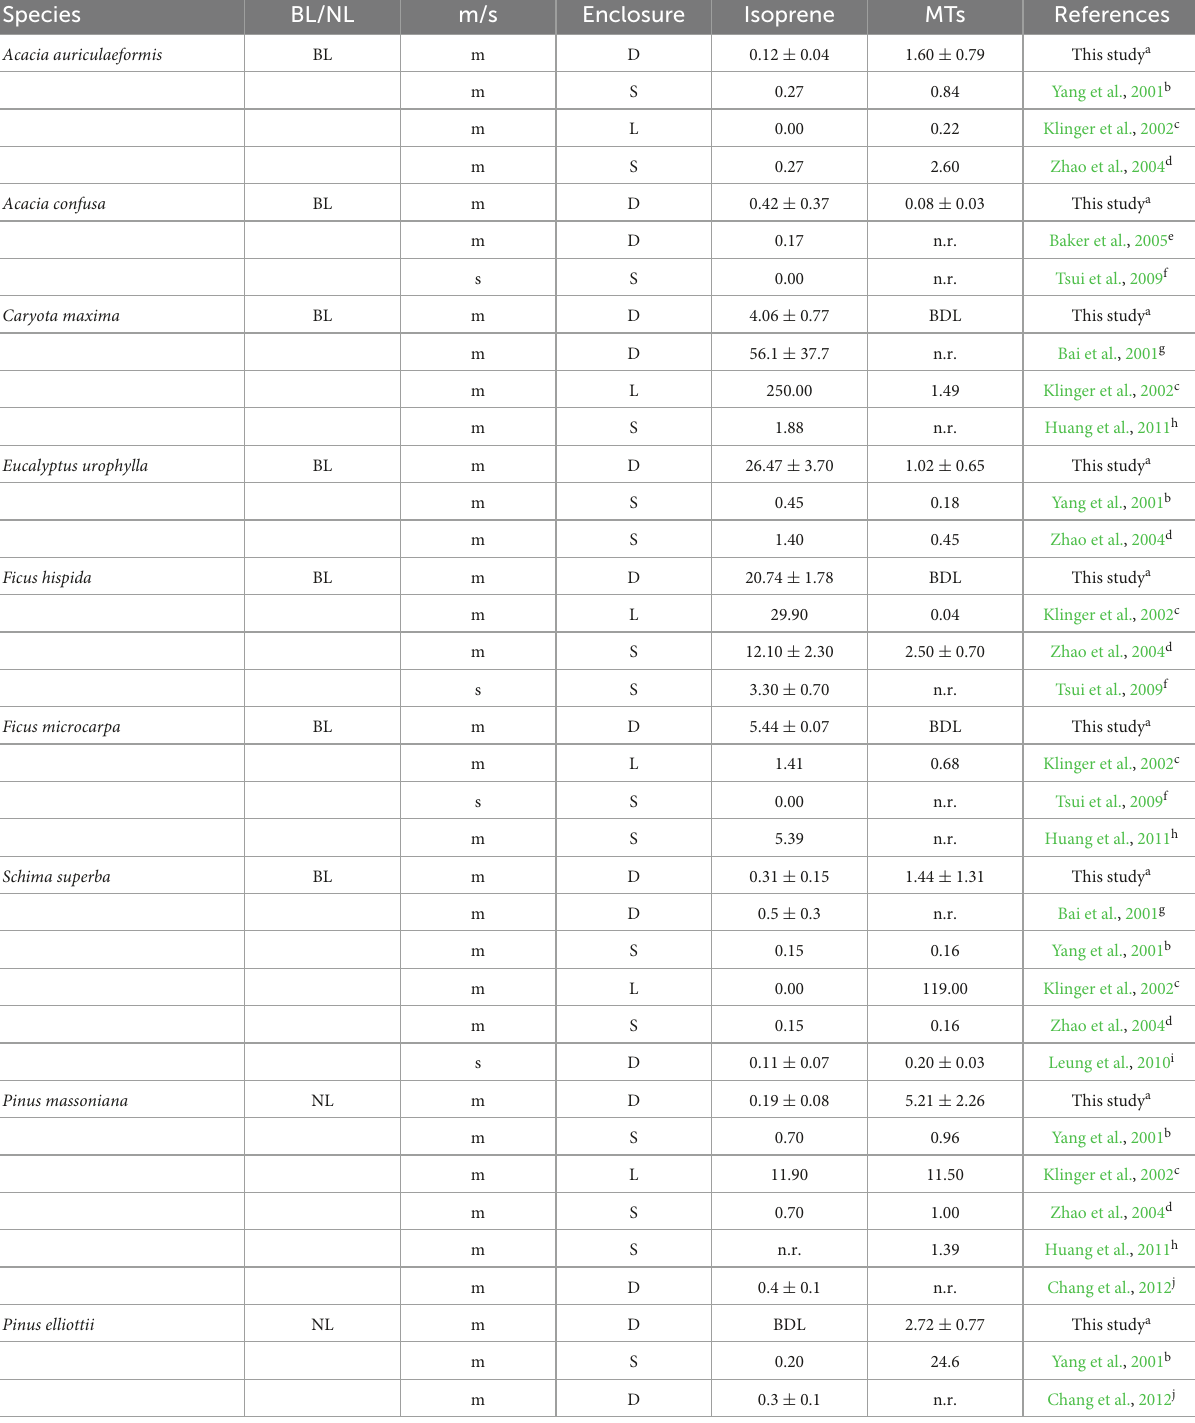
TABLE 2 Comparison of E s for isoprene and monoterpenes (MTs) with previous studies in this subtropical region. Species BL/NL m/s Enclosure Isoprene